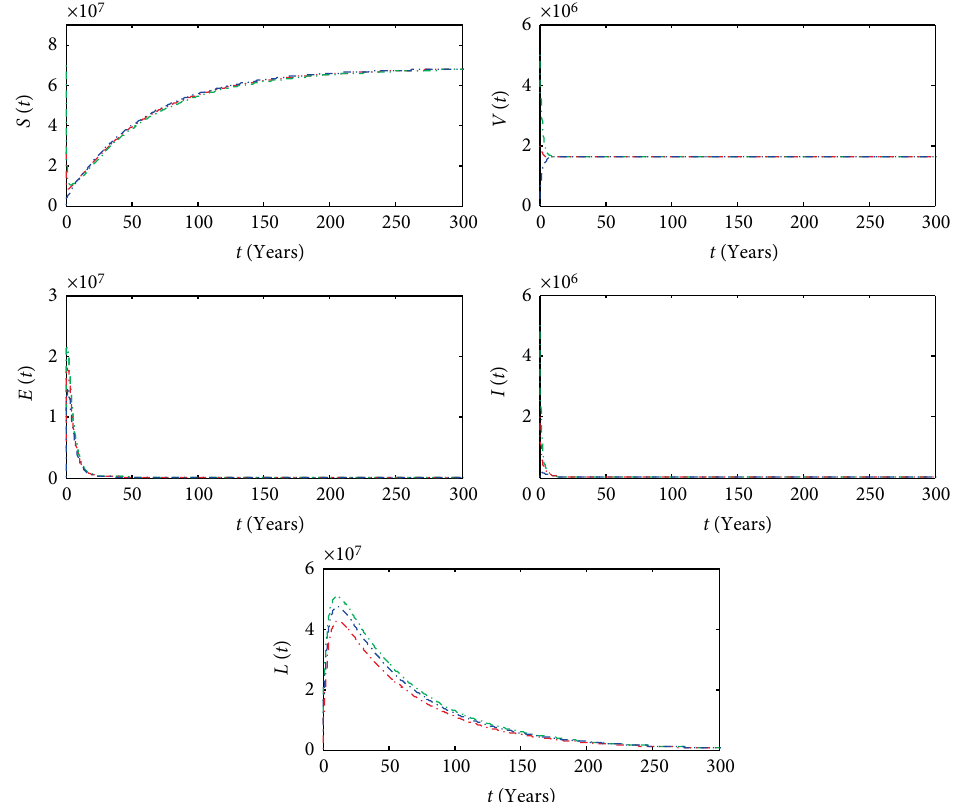
Figure 3: The plot shows for different initial values of (𝑆, 𝑉, 𝐸,𝐼, 𝐿) , the solution of the model converges to the disease-free equilibrium point ∗ 7 6 for R g = 0.65 𝑃 10 , 1.61 10 , 0,0, 0) 0 = (6.84 × ×